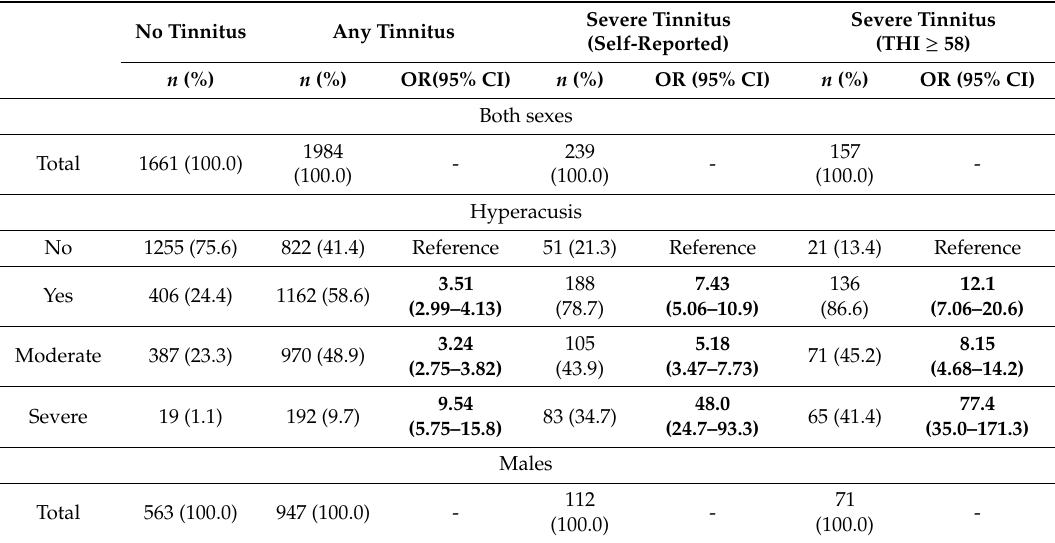
Table 3. Odds ratios (OR) a for any tinnitus, severe tinnitus (THI ≥ 58), and self-reported severe tinnitus, and corresponding 95% confidence intervals (CI), according to hyperacusis. Sweden, 2016–2018. Severe Tinnitus No Tinnitus Any Tinnitus